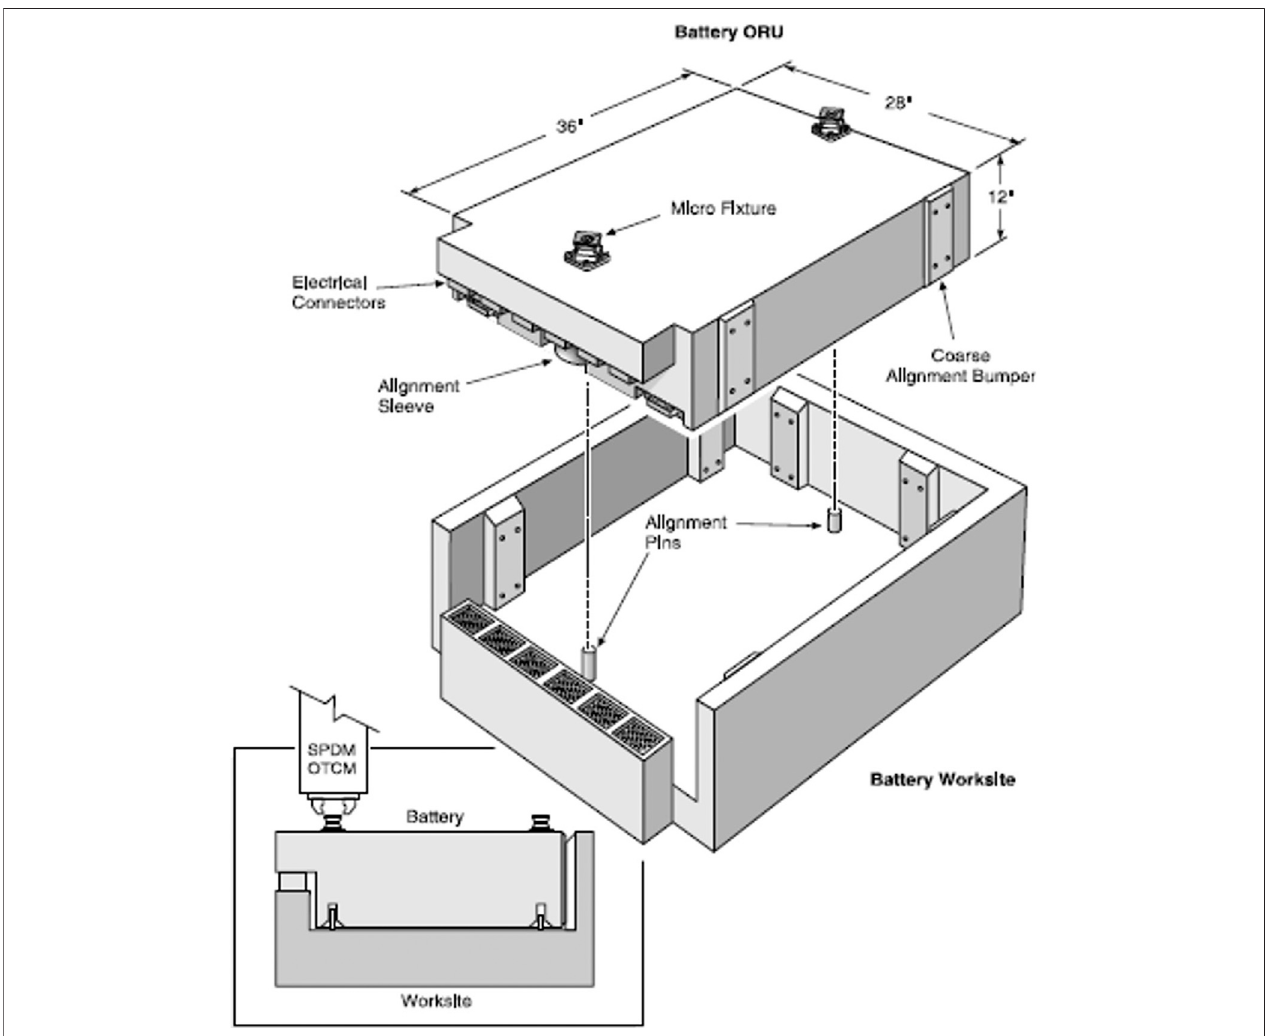
FIGURE 2 | An ISS battery and housing with three peg-in-hole contact pairs (Ma and Carr, 1998).